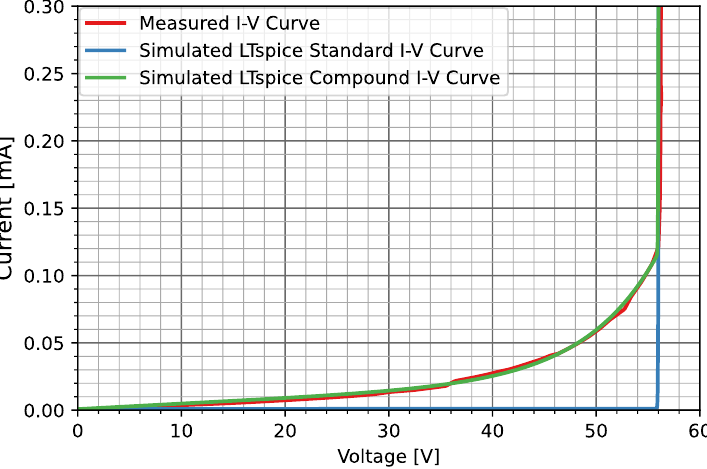
Figure 22. Measured and simulated reverse bias plots for the 10SQ045 diode.